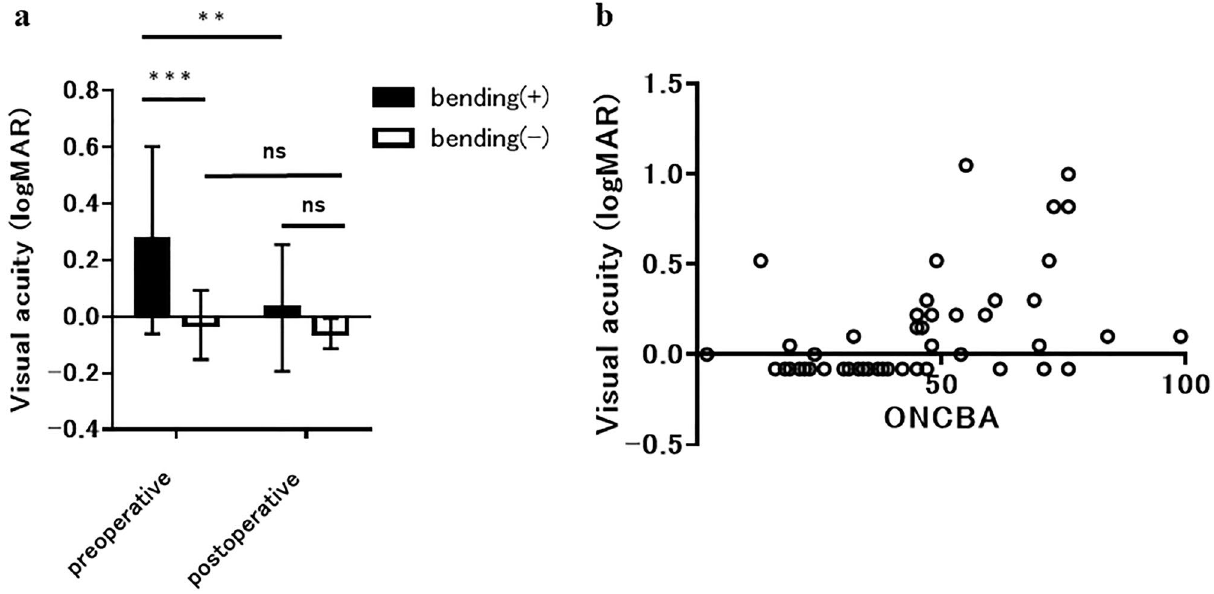
Figure 2. Assessment of best-corrected visual acuity (BCVA) in patients with the sellar and suprasellar tumor. ( a ) Comparison of BCVA between eyes with and without optic nerve bending before and after surgery. The preoperative BCVA of eyes with optic nerve bending was significantly lower than those without optic nerve bending (**p < 0.001). BCVA was significantly improved after tumor resection in eyes with optic nerve bending (**p < 0.001). There was no significant difference between the pre- and postoperative BCVA of eyes without optic nerve bending (p = 0.40). ( b ) Graphs showing the correlation between the ONCBA and preoperative BCVA in 50 eyes of 25 patients. The ONCBA had a positive correlation with preoperative BCVA (r = 0.4986, p = with and without optic nerve bending. Notably, the GCL + IPL thickness in the temporal sectors was significantly lesser in bending eyes than in non-bending eyes. (Fig. 3e,f). Tumor-induced optic nerve bending at the entrance of the optic canal causes compression of the bony margin of the optic canal and stretching of the local optic nerve. Local compression of the optic nerve by bending in the narrow space of the optic canal’s entrance may cause more dysfunction of the entire optic nerve cord than local compression in the relatively wide space of the optic chiasm, which may affect not only the nasal GCL + IPL but also the temporal GCL + IPL. Transsphenoidal surgery is an effective and safe treatment for most patients with pituitary adenomas and is expected to improve visual function 9 . Eyes with sellar and suprasellar tumors with optic nerve bending had severe visual impairment, but visual acuity improved with tumor resection (Fig. 2a). In contrast, eyes with optic nerve bending that showed little improvement in postoperative BCVA showed a significant decrease in preop- erative GCL + IPL thickness (Fig. 4). Several factors have been previously investigated to predict visual recovery after optic chiasm decompression surgery. Retinal nerve fiber layer (RNFL) thinning, which reflects the loss of ganglion cell axons, is a predictor of poor visual recovery after surgery due to the optic chiasm compression and permanent denervation of the optic radiations and visual cortex 10–12 . Previous reports have shown that eyes with a normal RNFL have improved visual fields postoperatively compared to eyes with a thin RNFL 13 . In a representative case of good visual outcome group (case 1), the preoperative OCT of the optic nerve bending eye showed only a mild decrease in GCL + IPL in the predominantly superior nasal sector, and the postoperative BCVA improved (Fig. 5). In contrast, in a representative case of poor visual outcome group (case 2), preoperative OCT of the optic nerve bending eye revealed severe GCL + IPL reduction in all sectors, and postoperative BCVA did not improve (Fig. 6). Based on this result, the preoperative GCL + IPL thickness measured by OCT may predict the prognosis of postoperative visual function in sellar and suprasellar tumors with optic nerve bending. Furthermore, retinal ganglion cell death may progress faster with optic nerve bending than with optic chiasm compression. Prolonged visual symptoms in pituitary adenomas have been reported to decrease the improvement in visual function after tumor resection 13 . In optic chiasm compression and optic nerve bending, the optic nerve compression period may be associated with a decrease in RGCs. This study did not examine the time between the onset of visual impairment and ophthalmologic evaluation. The duration since optic nerve bending onset may affect visual impairment; hence, further studies are needed in the future. A previous report indicated that measuring RGCs may identify nerve fiber damage before RNFL in homonymous hemianopia 14 . Although not examined in this study, sellar and suprasellar tumors with optic nerve bending may also show changes in RNFL following RGCs. The limitations of our study include its retrospective nature, single-center design, and small sample size. Further research needs to include a large multi-center study. In conclusion, sellar and suprasellar tumors with optic nerve bending cause thinning of the RGCs on the nasal and temporal sides. Eyes with optic nerve bending and severe retinal ganglion cell thinning had poor visual acuity even after tumor resection, and preoperative GCL + IPL thickness may be a prognostic factor for postoperative visual acuity.